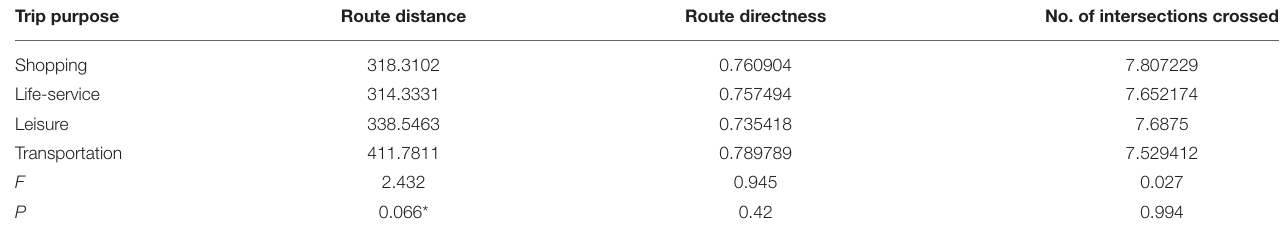
TABLE 4 | One-way ANOVA between trip purpose and network